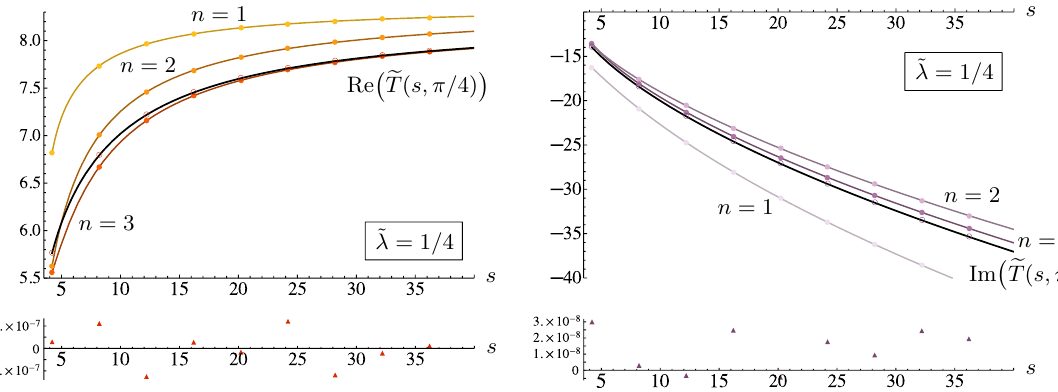
Figure 8 . Numerical tests of the integral equation at coupling ˜ λ = 1 / 4 and scattering angle θ = β − α = π/ 4 for a range of s (having set m = 1 ). The left panel compares the real part of P n λ L +1 e T ( L ) ( s, θ ) (orange) up to three-loop order. The right panel compares e T ( s, θ ) (black) to L =0 the imaginary part, with all-order results in black, and perturbative results in purple. The deviation between the two sides of the integral equation for the all-orders ansatz is shown in the lower